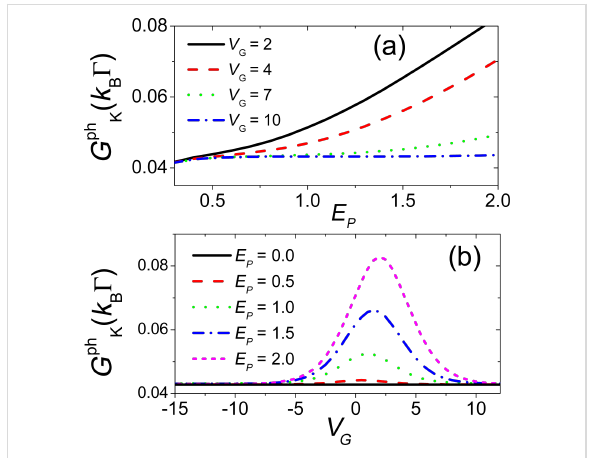
Figure 6: Phonon thermal conductance in the linear response regime, in the range of validity of the adiabatic approximation. Panel (a): Phonon thermal conductance (in units of k B Γ ) as a function of electron–vibration coupling E P (in units of ) for different values of gate voltage V G (in units of ). Panel (b): Phonon thermal conduct-